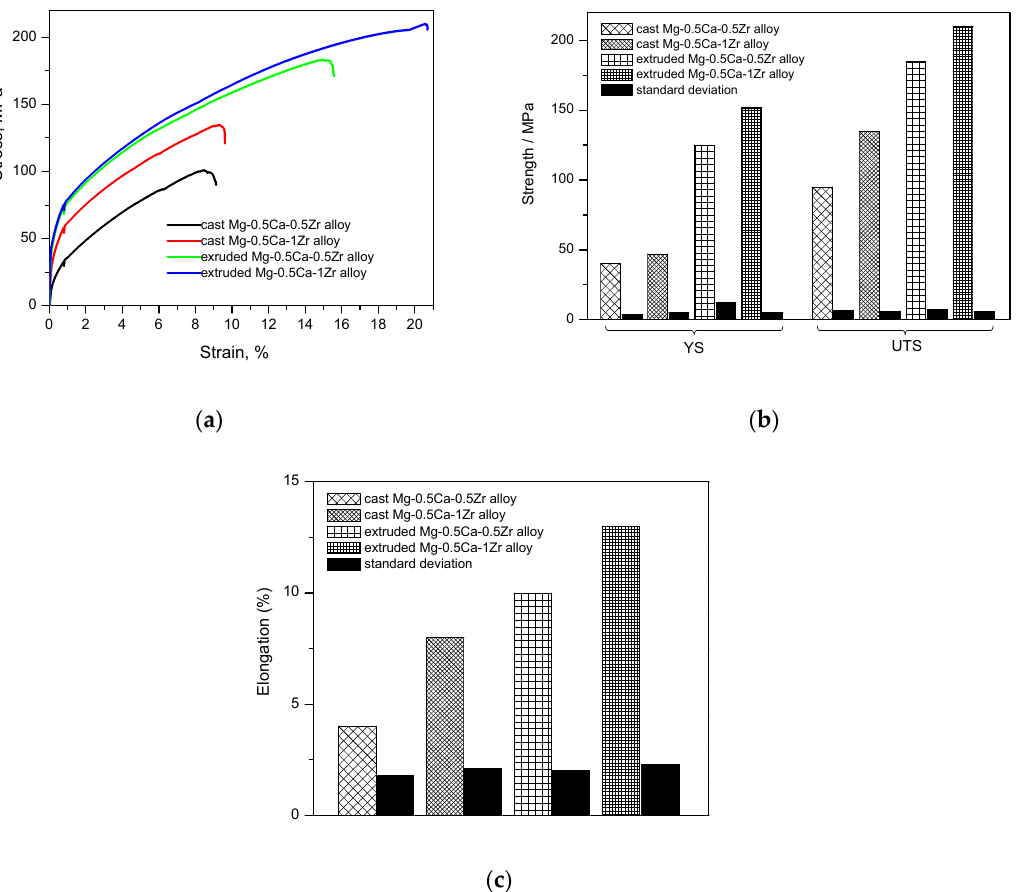
Figure 10. ( a ) Nominal tensile strain stress curves, ( b ) tensile strength and ( c ) elongation of the as-cast and as-extruded Mg alloys. Table 2. Lattice parameters of the α -Mg phase. Composition (wt.%)